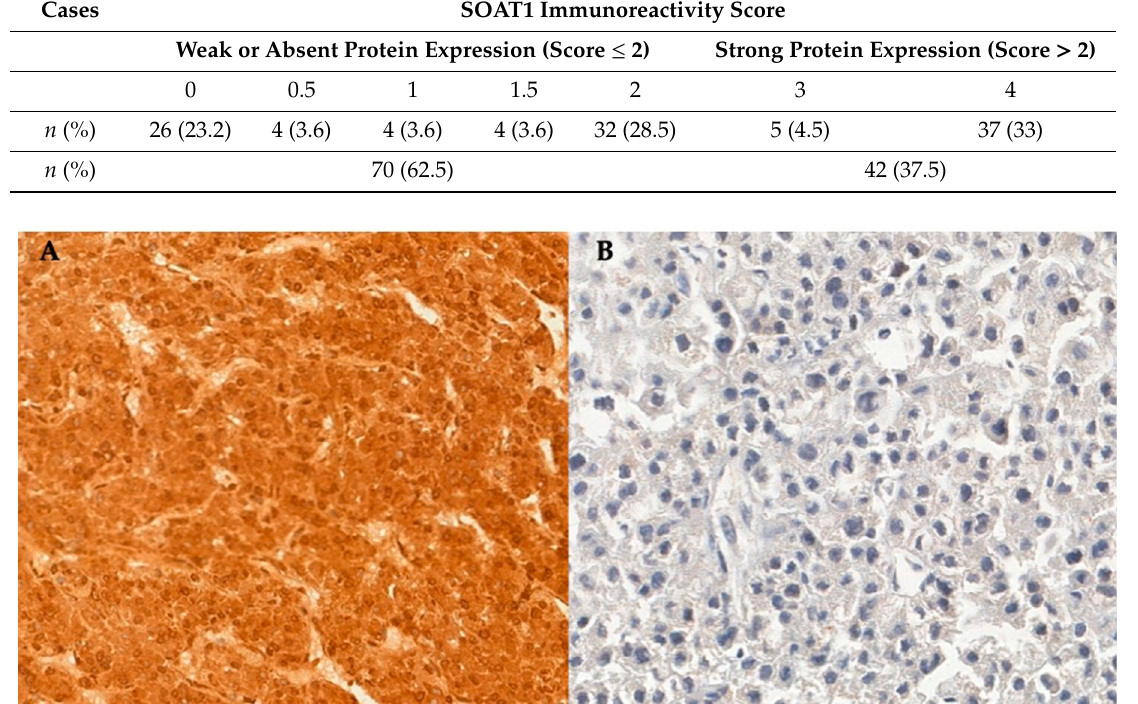
Table 1. Frequency of immunoreactivity scores (0–4) for Sterol-O-acyl transferase 1 (SOAT1) protein in 112 adrenocortical carcinomas and categorization of cases according to protein expression.